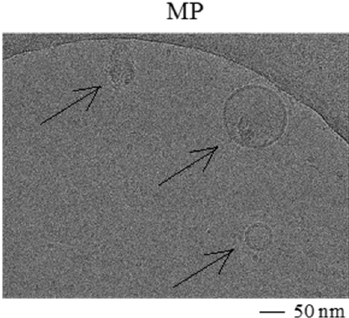
Figure 1. Schematic overview of EV, EV γ , MP and MP γ generation.